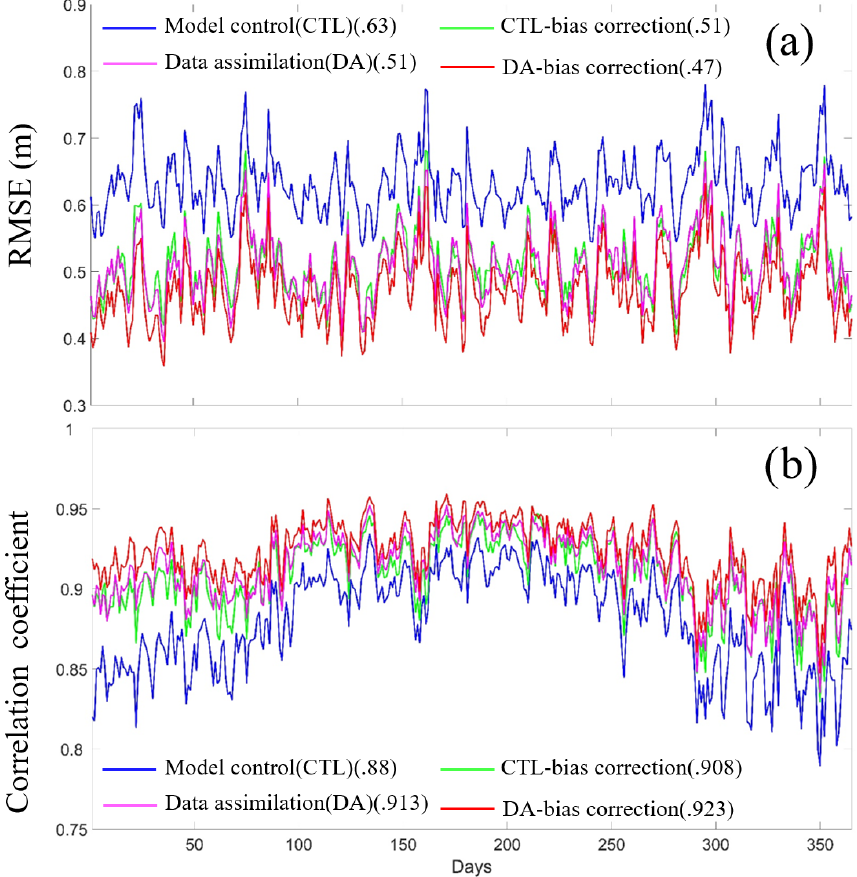
Figure 11. The time series of (a) RMSEs and (b) spatial correlation coefficients produced by the model control run (blue), data assimilation (pink) and their corresponding bias corrections (green and red) combining three wave model assimilation results (WAM, WW3 and SWAN) globally averaged over 1